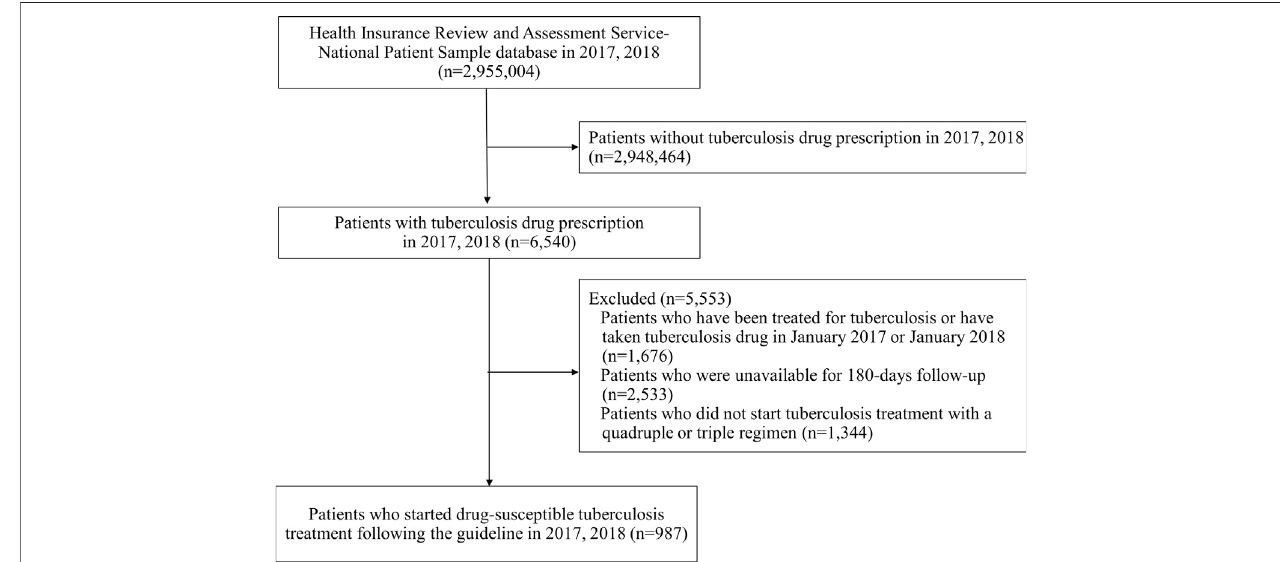
FIGURE 2 | Study fl owchart for patient selection of drug-susceptible tuberculosis adherence study.